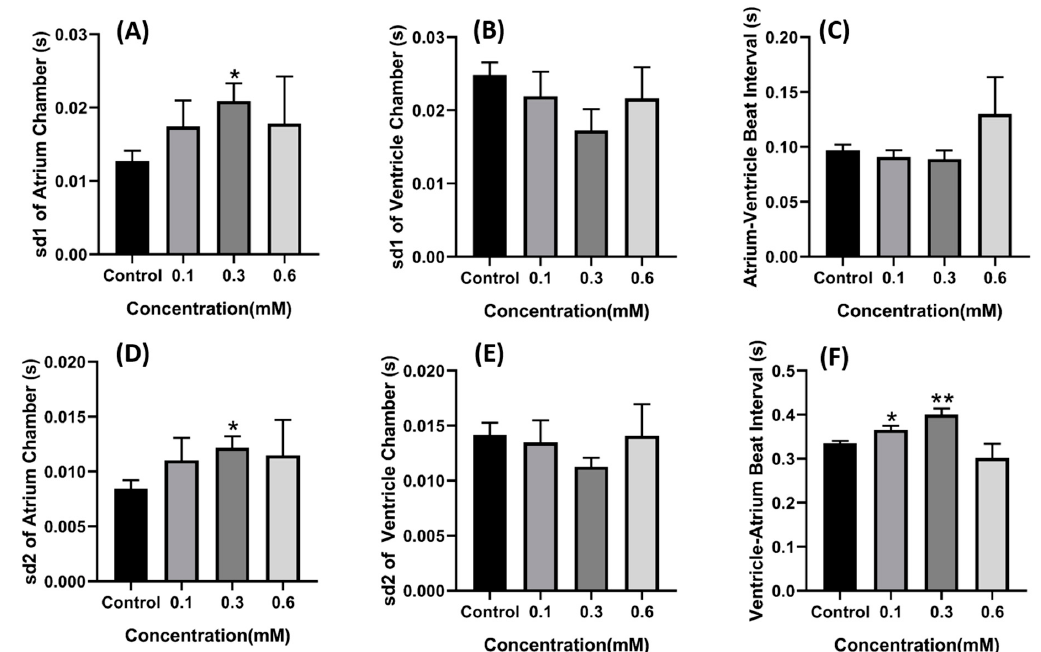
Figure 4. Cardiac rhythm alteration induced by CuO nanoparticle exposure in zebrafish larvae. ( A ) Atrium SD1. ( B ) Ventricle SD1. ( C ) Atrium–ventricle interval. ( D ) Atrium SD2. ( E ) Ventricle SD2. ( F ) Ventricle–atrium interval. Data were statistically analyzed using a Brown–Fosythe one-way ANOVA with Dunnett post-hoc test for multiple comparisons. * p < 0.05, ** p < 0.005.